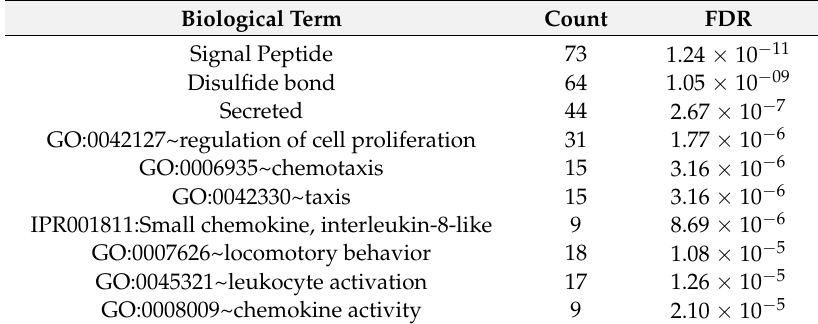
Table 2. FDR-ranked top 10 biological terms significantly enriched in the set of 193 DE-genes when comparing the expression profile for 499 genes between MSS and MSI-high cases.